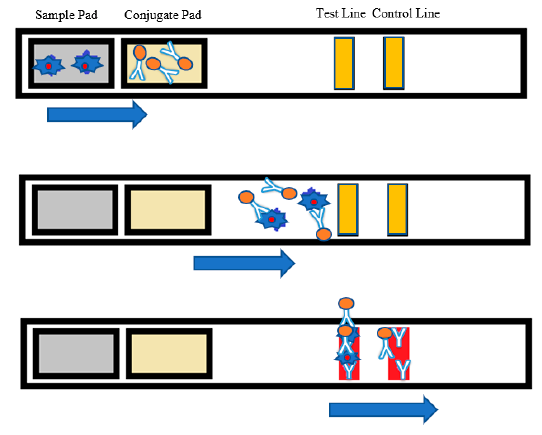
Figure 1. Lateral flow assay (LFA) strip architecture where the analyte is detected in the test line, and the red control line indicates that the test was performed.